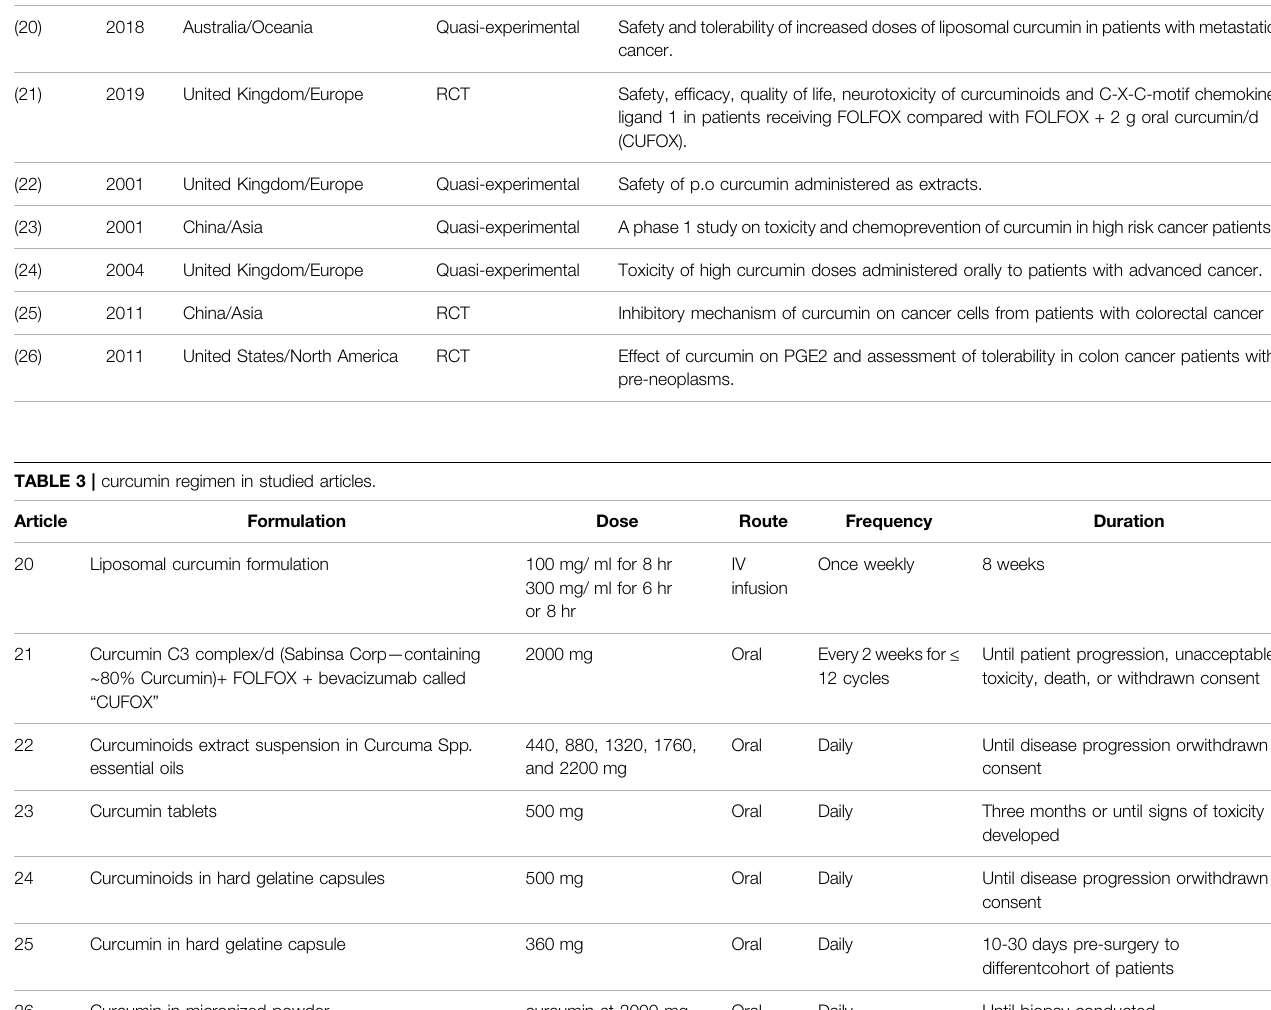
TABLE 2 | Study objectives of included articles.